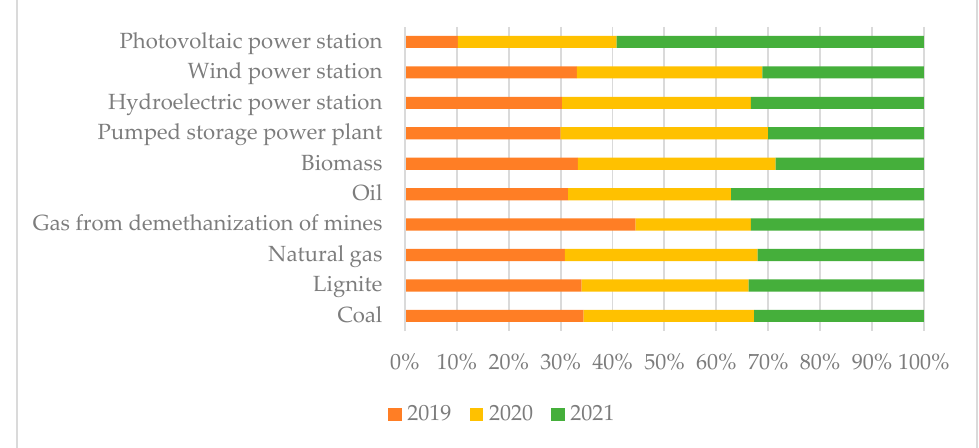
Figure 2. The structure of electricity production in Poland in 2019–2021. Source: authors’ own studies, developed from [40].